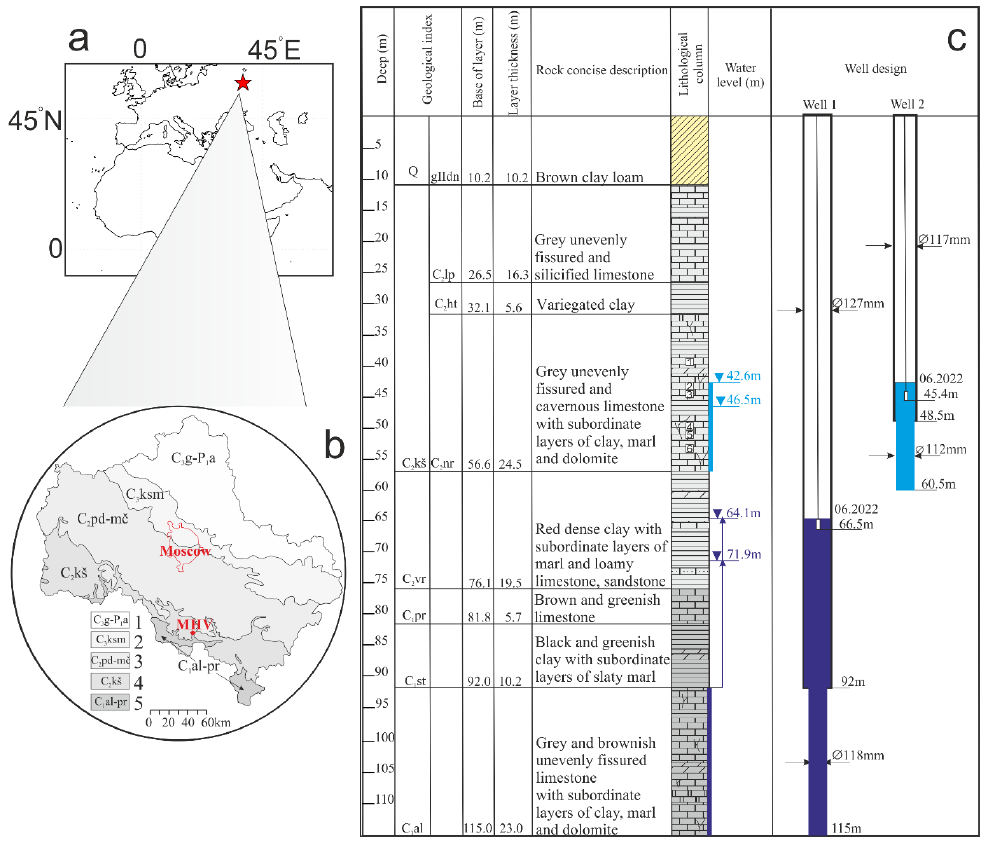
Figure 1. Experimental area location ( a ), hydrogeological scheme of Moscow region ( b ) and geological cross section with well design at the territory of the Mikhnevo (MHV) geophysical observatory ( c